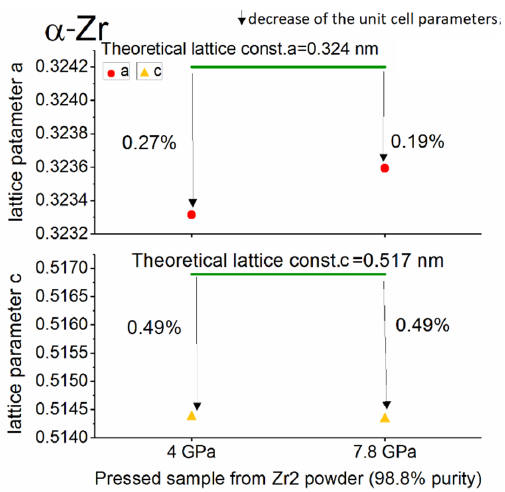
Figure 5. The change of the lattice parameters (in %) for the α -Zr phase in the pressed sample compacted from Zr 2 powder (98.8% purity).